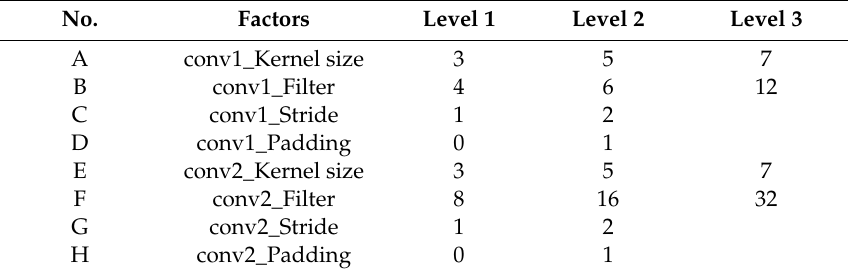
Table 3. A ff ecting factor parameters of the CNN.